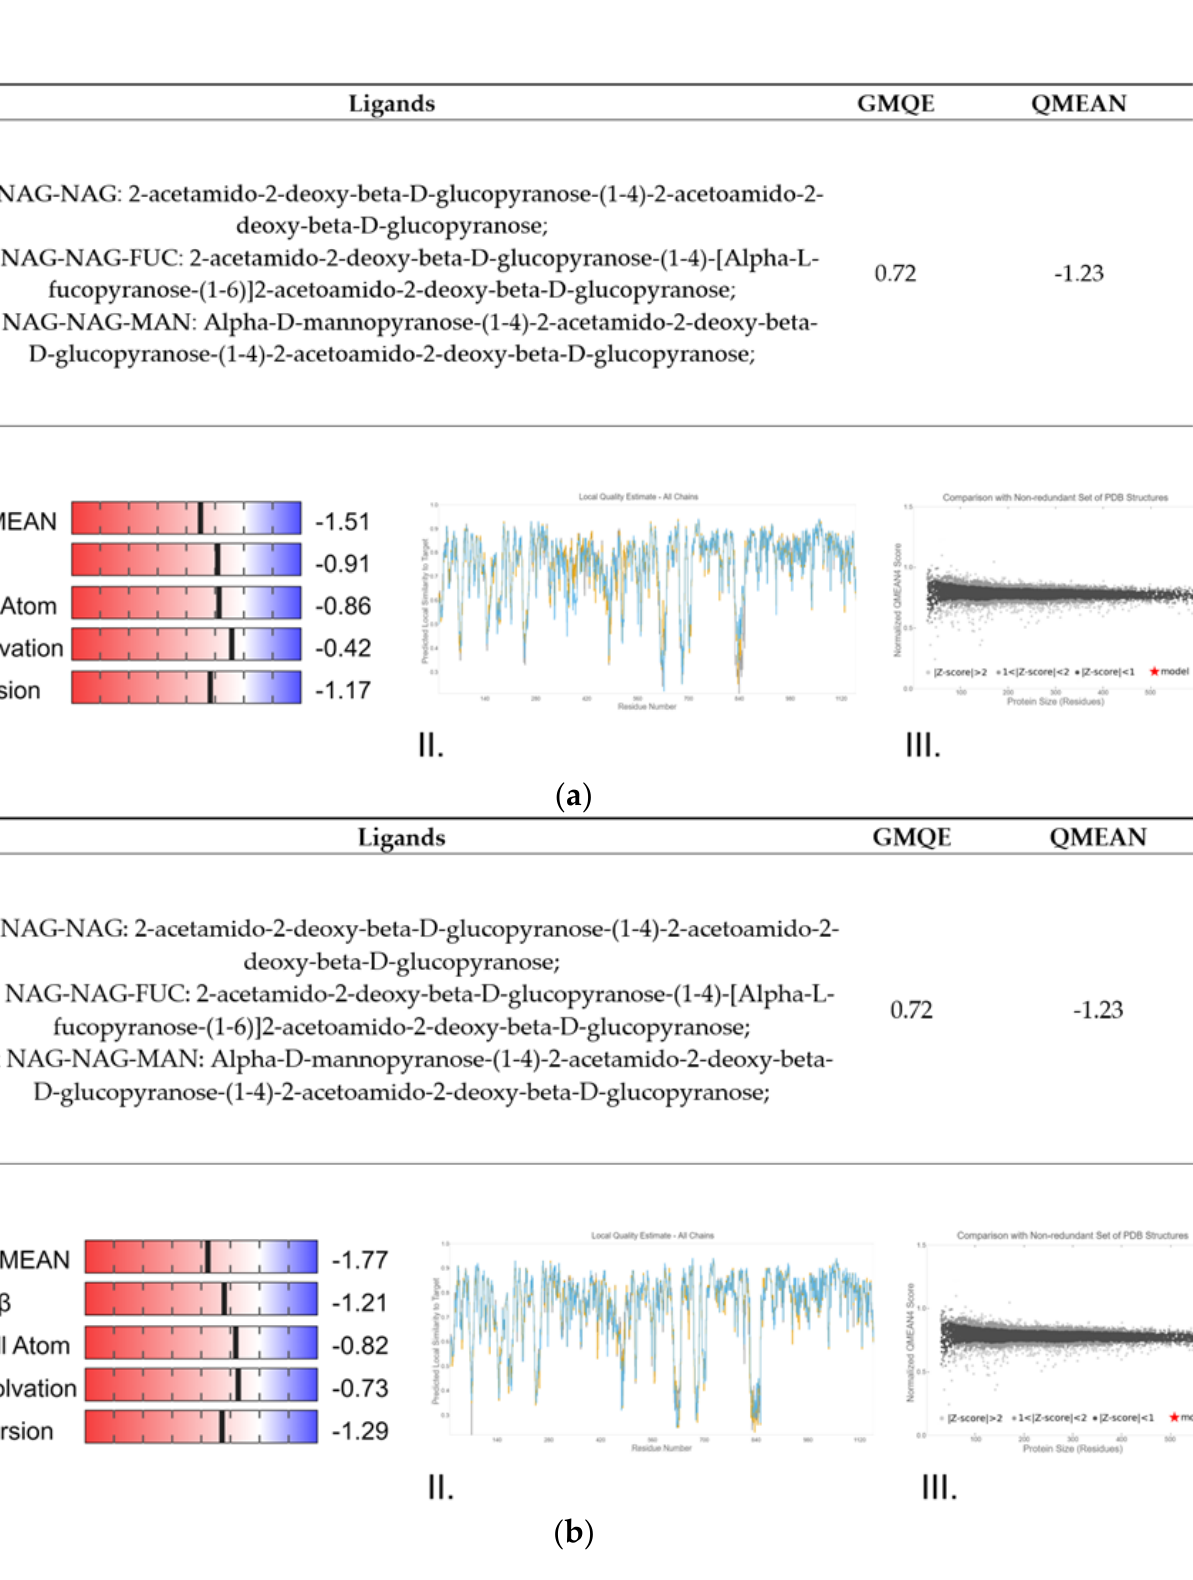
Figure 3. Protein Structure Homology-Modelling of the spike for ( a ) Spanish variant and ( b ) British variant. Subsections: I. QMEAN Z-Scores. II. QMEANDisCo Local. III. Protein size. Model-Template alignment shows how well template structure and sequence align and what parts of the model were used. Better alignment is marked in blue, worse alignment and modeling in red. Secondary structure is also indicated with tubes for α -helix and arrows for β -sheet. Both QMEANs scores ( − 1.23 and − 1.25) show extremely high model quality.